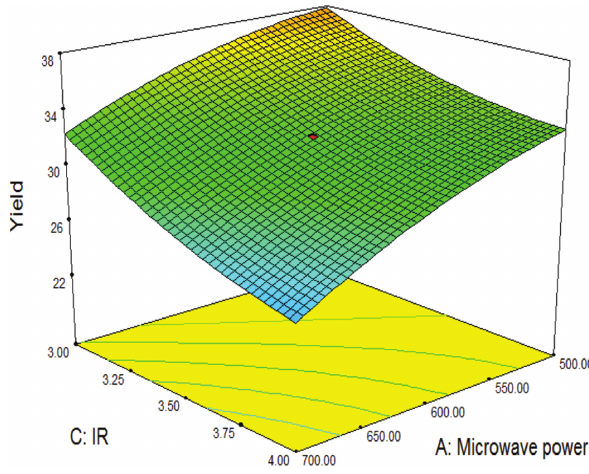
Figure 4: Three-dimensional response surface plot of yield: effect of microwave power and IR on the yield (activation time: 20min).